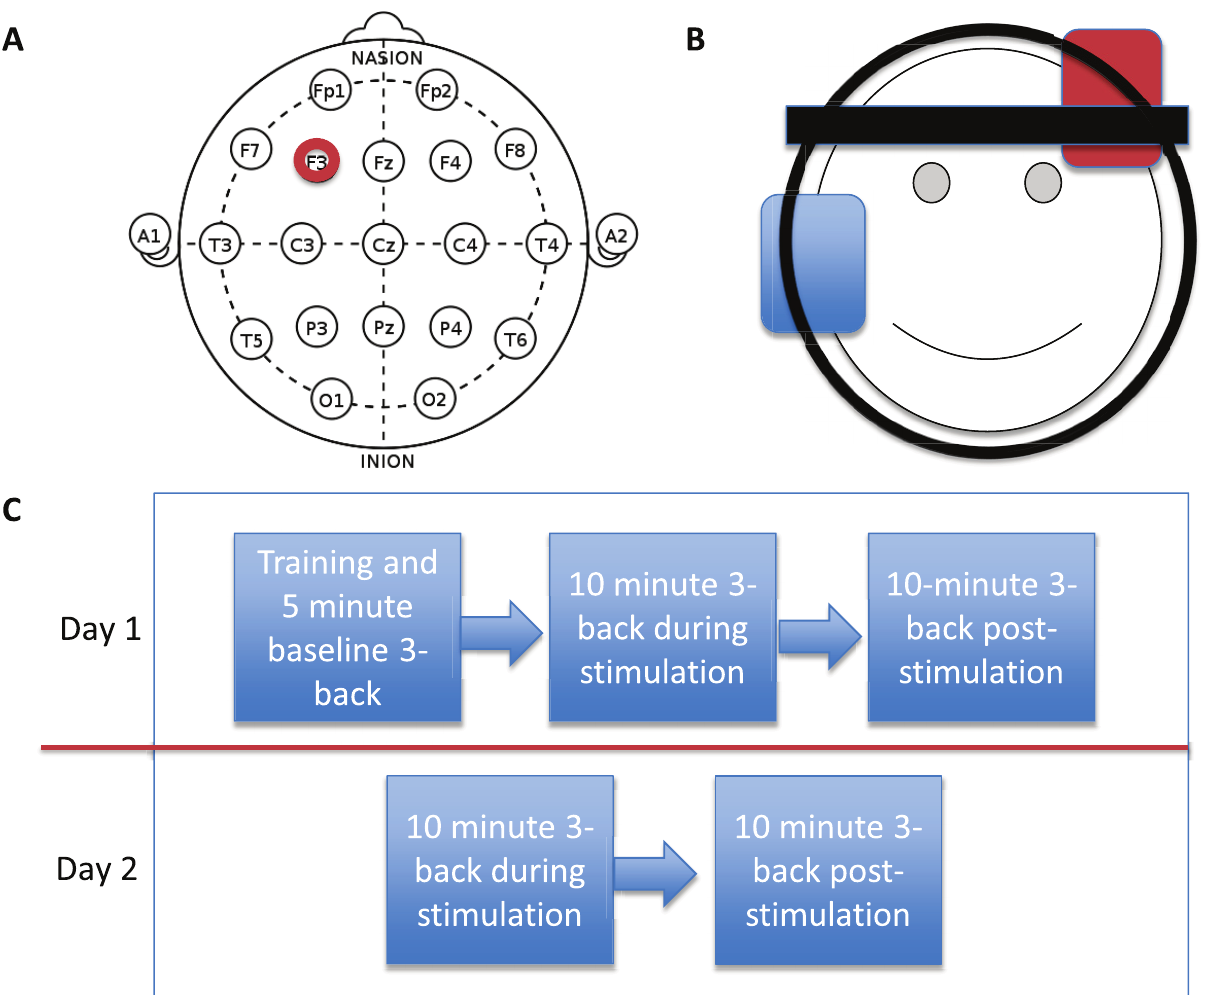
Figure 2. tDCS electrode montage and study design. A , B ) The excitatory anodal electrode (red) was positioned using a 10–20 standard electroencephalography electrode cap under F3, which corresponds to dorsolateral prefrontal cortex. The inhibitory cathodal electrode (blue) was positioned on the contralateral cheek. C ) Timeline of events in the study. Participants performed the 3-back on five separate occasions, once at baseline on day 1, twice during and twice following stimulation on both